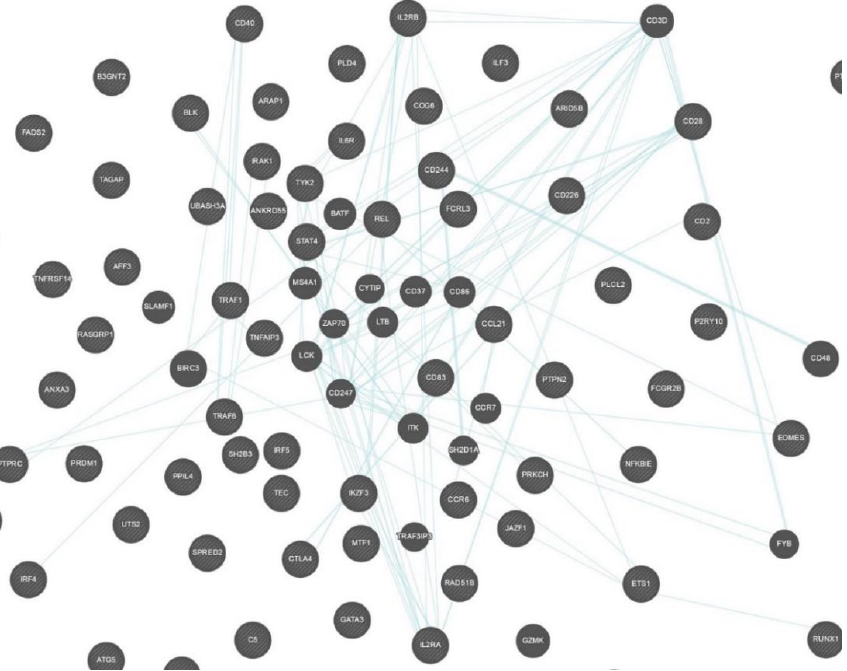
Figure 6. Gene–gene interaction network predicted by GeneMANIA showing only co-localized genes in pathways. This figure was downloaded as a high-quality image file from GeneMANIA v3.5.1 (https://genemania.org/, accessed on 25 February 2021).